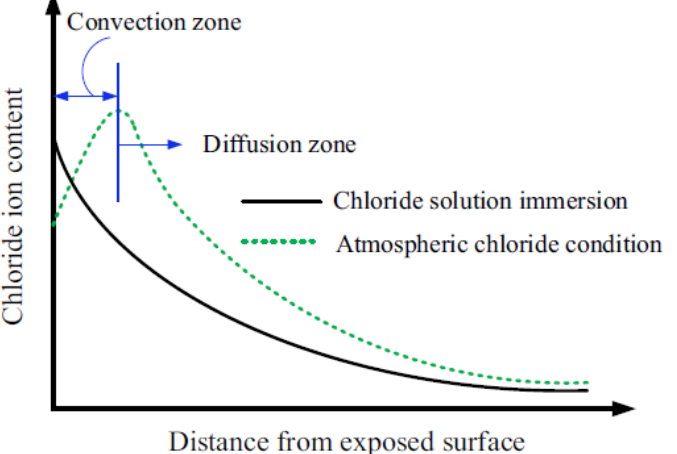
Figure 3. Qualitative expression of the chloride penetration curves [24].